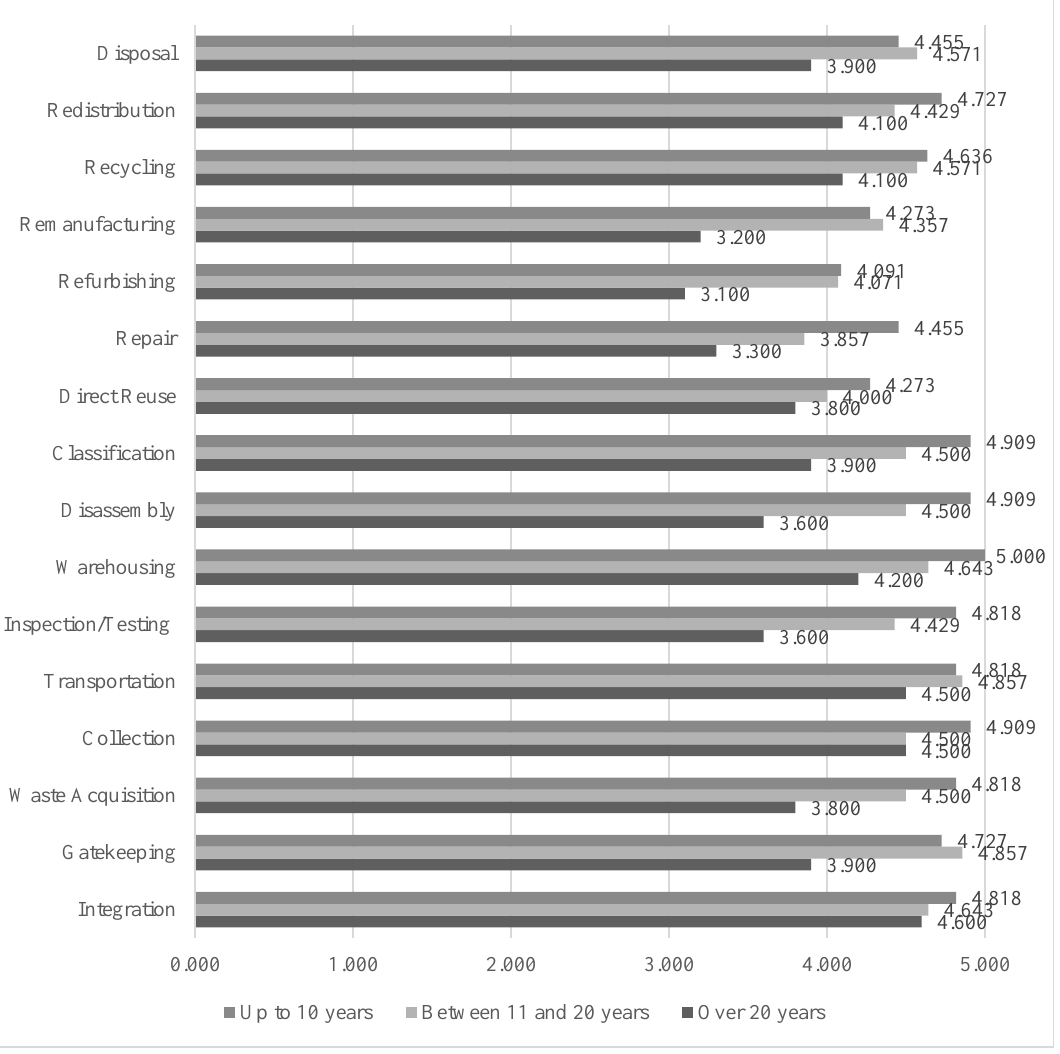
Figure 3. Averages are assigned to each activity by respondents’ experience. Source: Authors (2021).